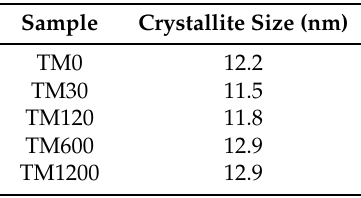
Table 1. The crystallite size of titania material based on X-ray diffraction (XRD) patterns in Figure 2.